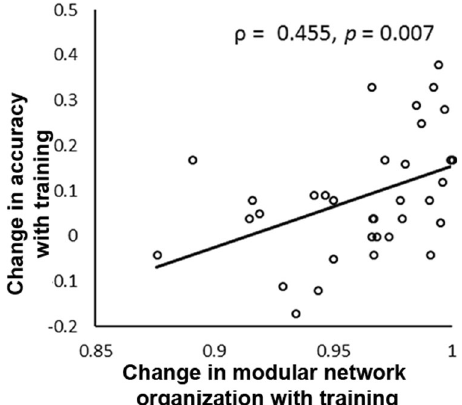
Fig. 4 Cognitive training-induced modular brain network reorganization predicts performance gains with training. Children who showed greater training-induced changes in modular brain network reorganization, as indexed by a mutual-information-based distance metric, exhibited larger gains in accuracy on addition problems with training ( ρ = 0.455, p = 0.007). N = 35